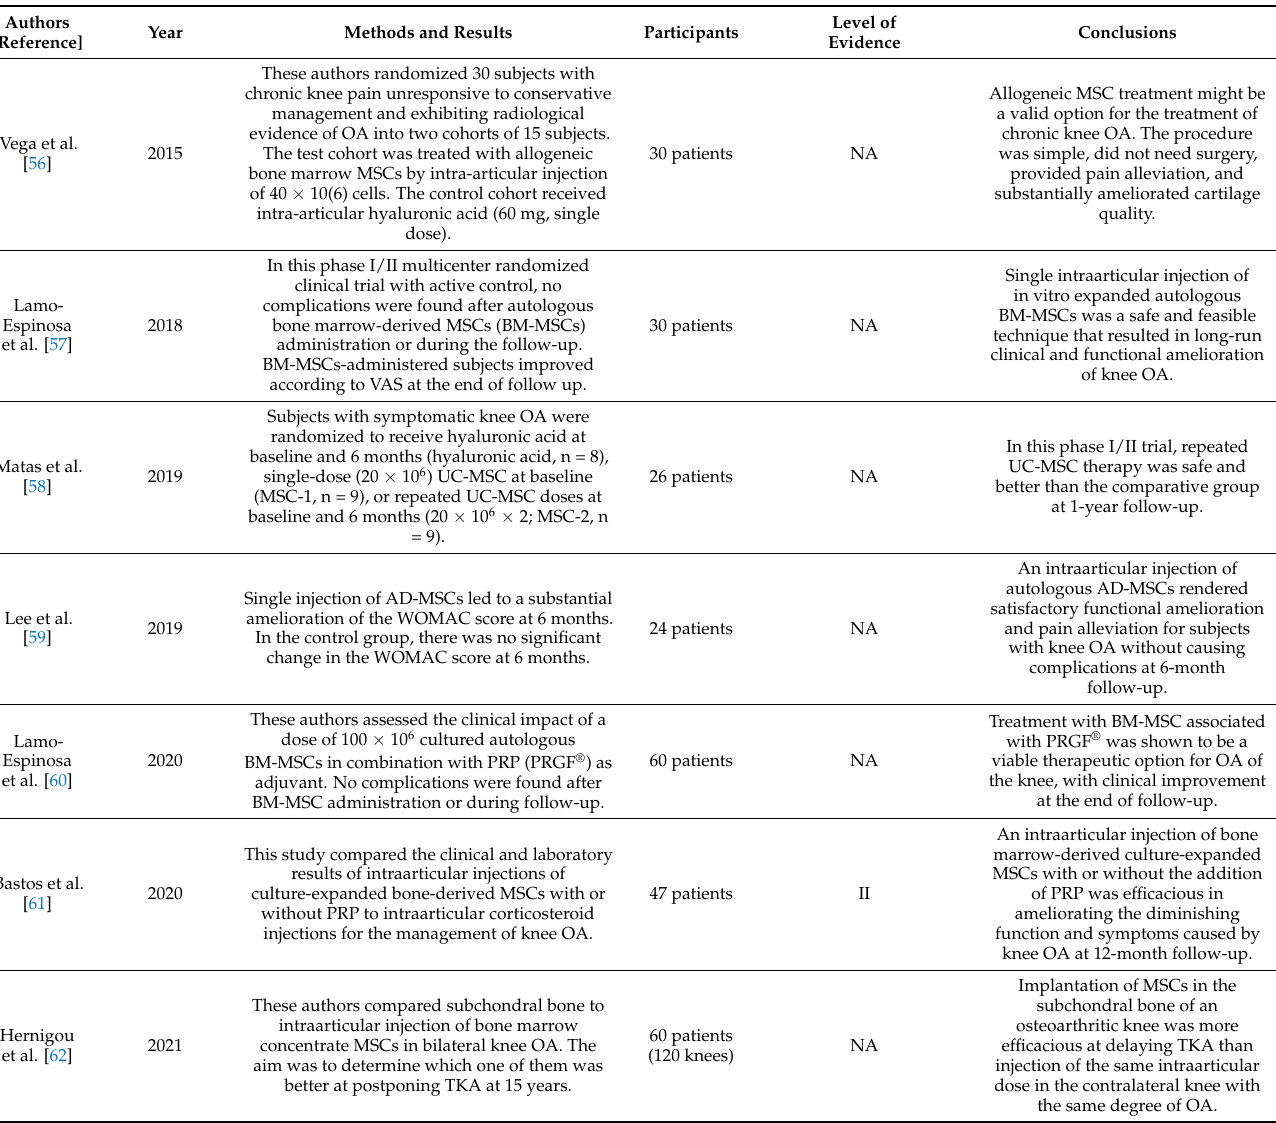
Table 2. Randomized clinical trials (RCTs) on the effectiveness of intraarticular injections of MSCs in knee